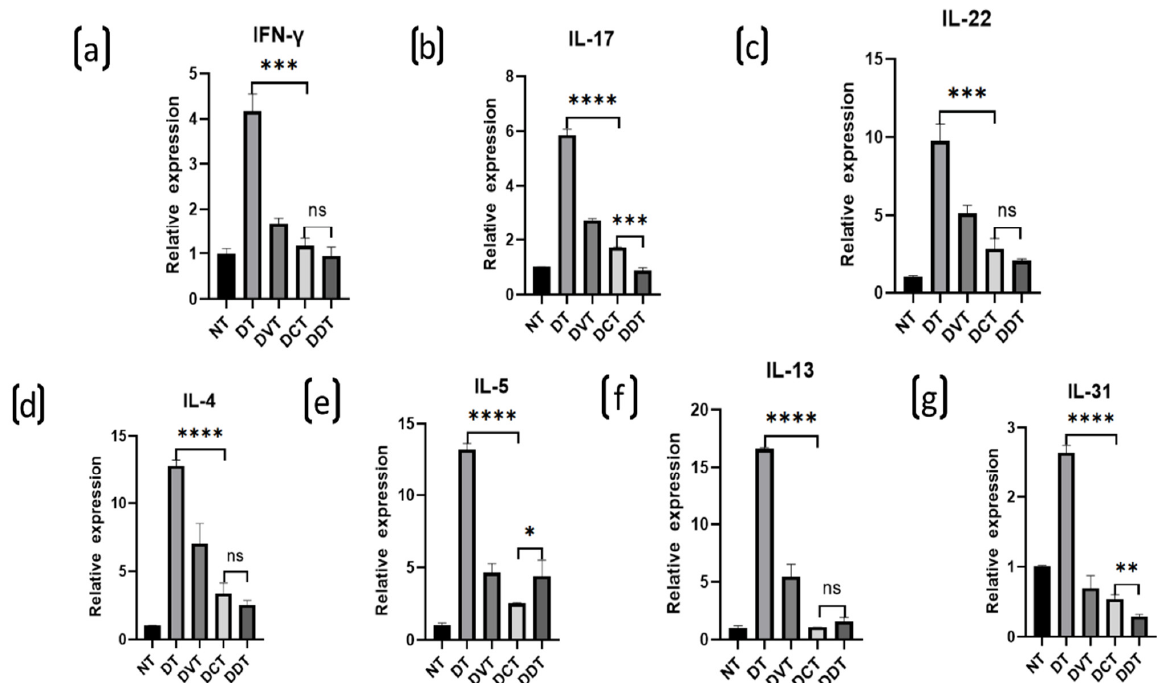
Figure 4. Expression levels of the inflammatory cytokines of dorsal skin lesions determined by qRT-PCR in each group of BALB/c mice. ( a , c , d , f ) The expression levels of IFN- γ , IL-22, IL-4, and IL-13 were increased significantly in the DT, DVT, DCT, and DDT groups in comparison to the NT group, the levels were significantly decreased in the DCT and DDT groups in comparison to the DT and DVT groups, and there was no significance between the DCT and DDT groups; ( b , g ) The expression levels of IL-17 and IL-31 were increased significantly in the DT, DVT, DCT, and DDT groups in comparison to the NT group, the levels were significantly decreased in the DCT and DDT groups when compared with the DT and DVT groups, and the levels were significantly higher in DCT group than DDT group; ( e )The expression level of IL-5 was increased significantly in the DT, DVT, DCT, and DDT groups in comparison to the NT group, the level was significantly decreased in the DCT and DDT groups when compared with the DT and DVT groups, and this level was significantly lower in DCT group than DDT group (data are presented as the mean ± S.E.M; ns: no significance, * p < 0.05, ** p < 0.01, *** p < 0.001, and **** p < 0.0001).